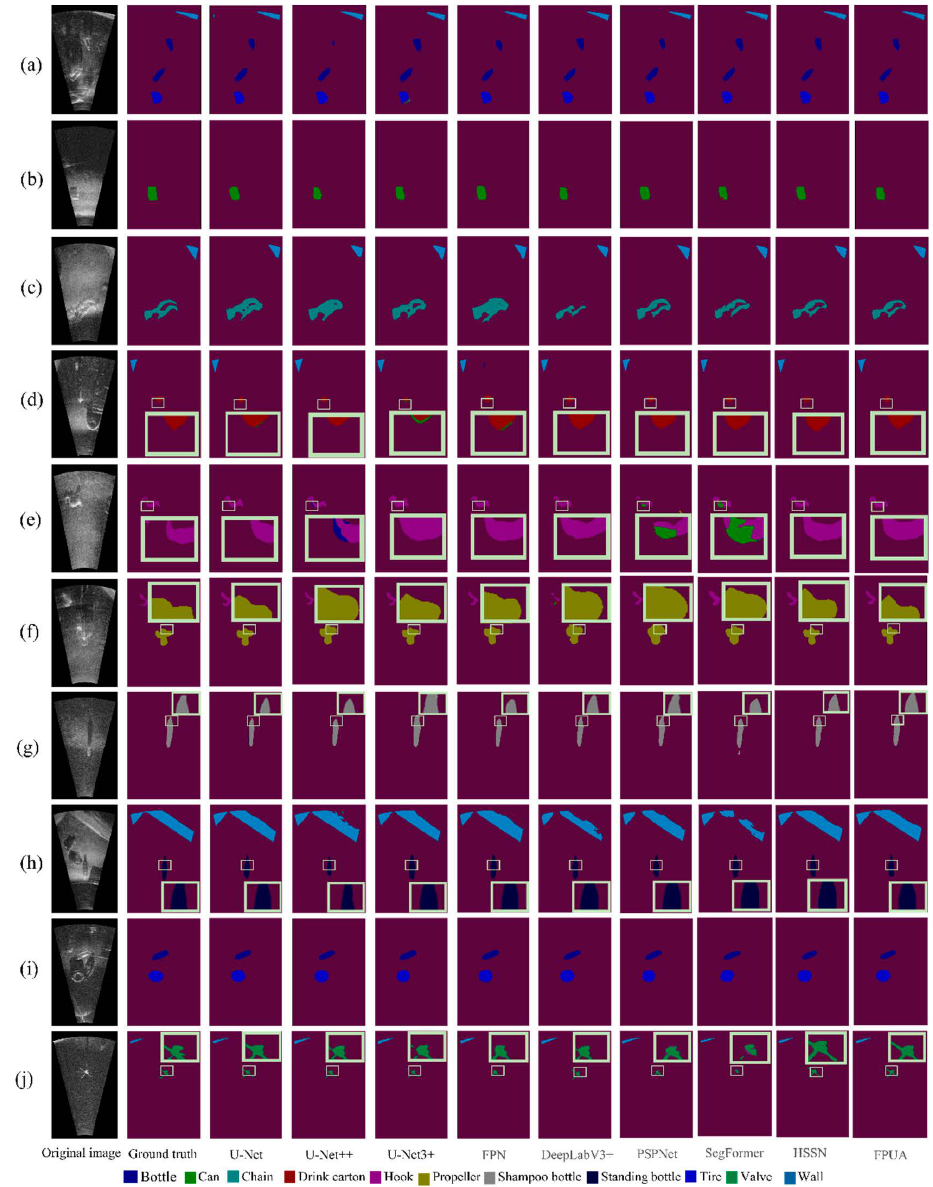
Figure 9. Segmentation results by target class for different models. Subfigure ( a ) shows the segmen- tation effect of bottle and wall, subfigure ( b ) shows the segmentation effect of can, subfigure ( c ) shows the segmentation effect of chain, subfigure ( d ) shows the segmentation effect of drink carton, subfigure ( e ) shows the segmentation effect of hook, subfigure ( f ) shows the segmentation effect of propeller, subfigure ( g ) shows the segmentation effect of shampoo bottle, subfigure ( h ) shows the segmentation effect of standing bottle, subfigure ( i ) shows the segmentation effect of tire, subfigure ( j ) shows the segmentation effect of wall. Subfigure h shows the segmentation of standing bottle, subfigure ( i ) shows the segmentation of tire, and subfigure ( j ) shows the segmentation of valve. The yellow box in the figure represents the enlargement of some details.